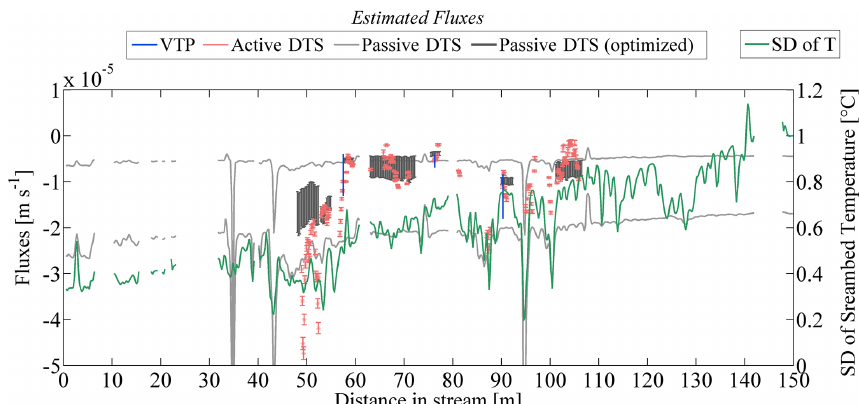
Figure 9. Comparison of flow estimated the 7 April 2016 using the vertical temperature profiles (VTPs), the passive DTS measurements, and the active DTS measurements. Results are compared with the evolution of SD of the temperature calculated from passive DTS measurements. The black arrows highlight localized groundwater